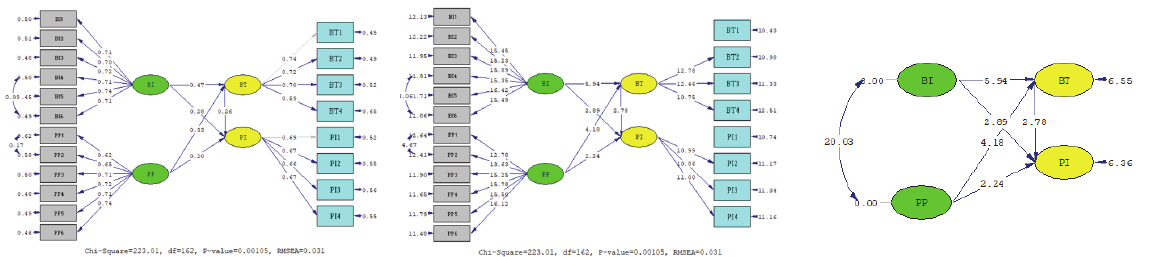
Latent Variable